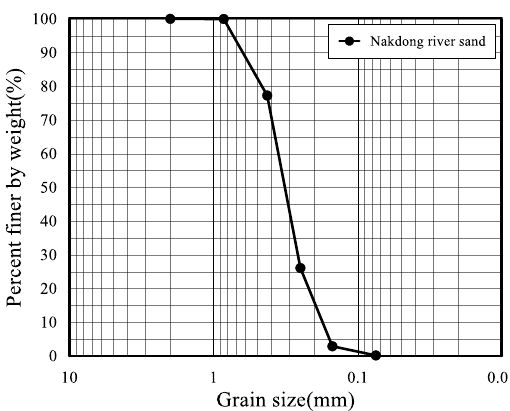
Figure 2. Grain size distribution curve of sand obtained from Nakdong River.